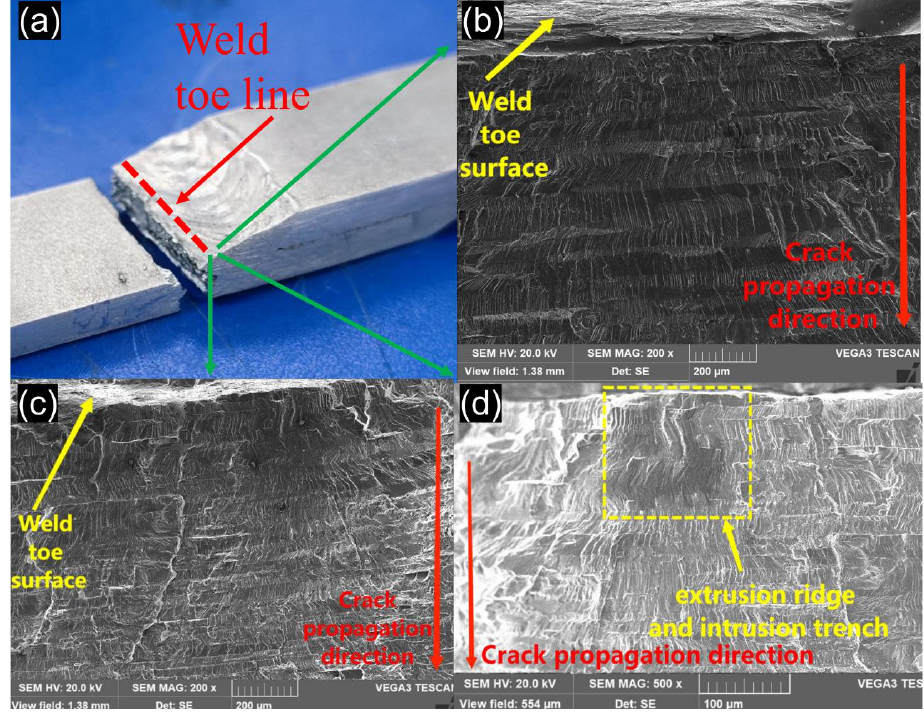
Figure 7. SEM image of weld toe line cracking: ( a ) weld toe line, ( b , c ) River pattern, ( d ) small fatigue source.